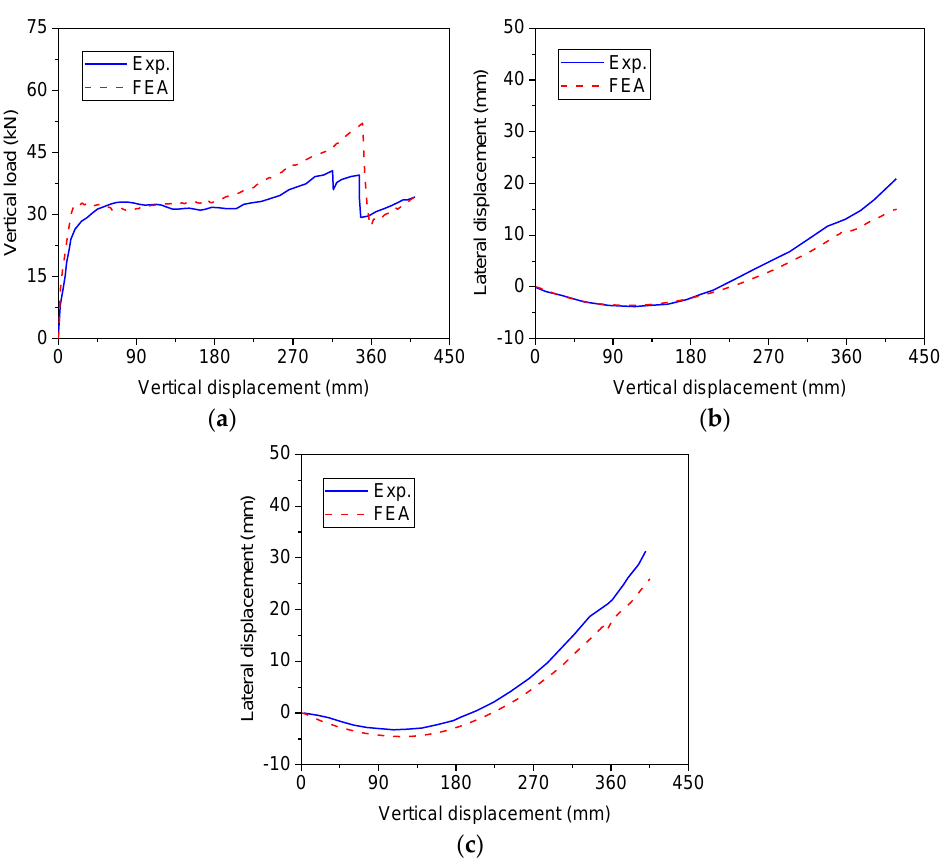
Figure 10. Comparisons between experimental and numerical results of two-storey frames: ( a ) load – displacement curve; ( b ) lateral displacement of first-storey column; ( c ) lateral displacement of second-storey column.